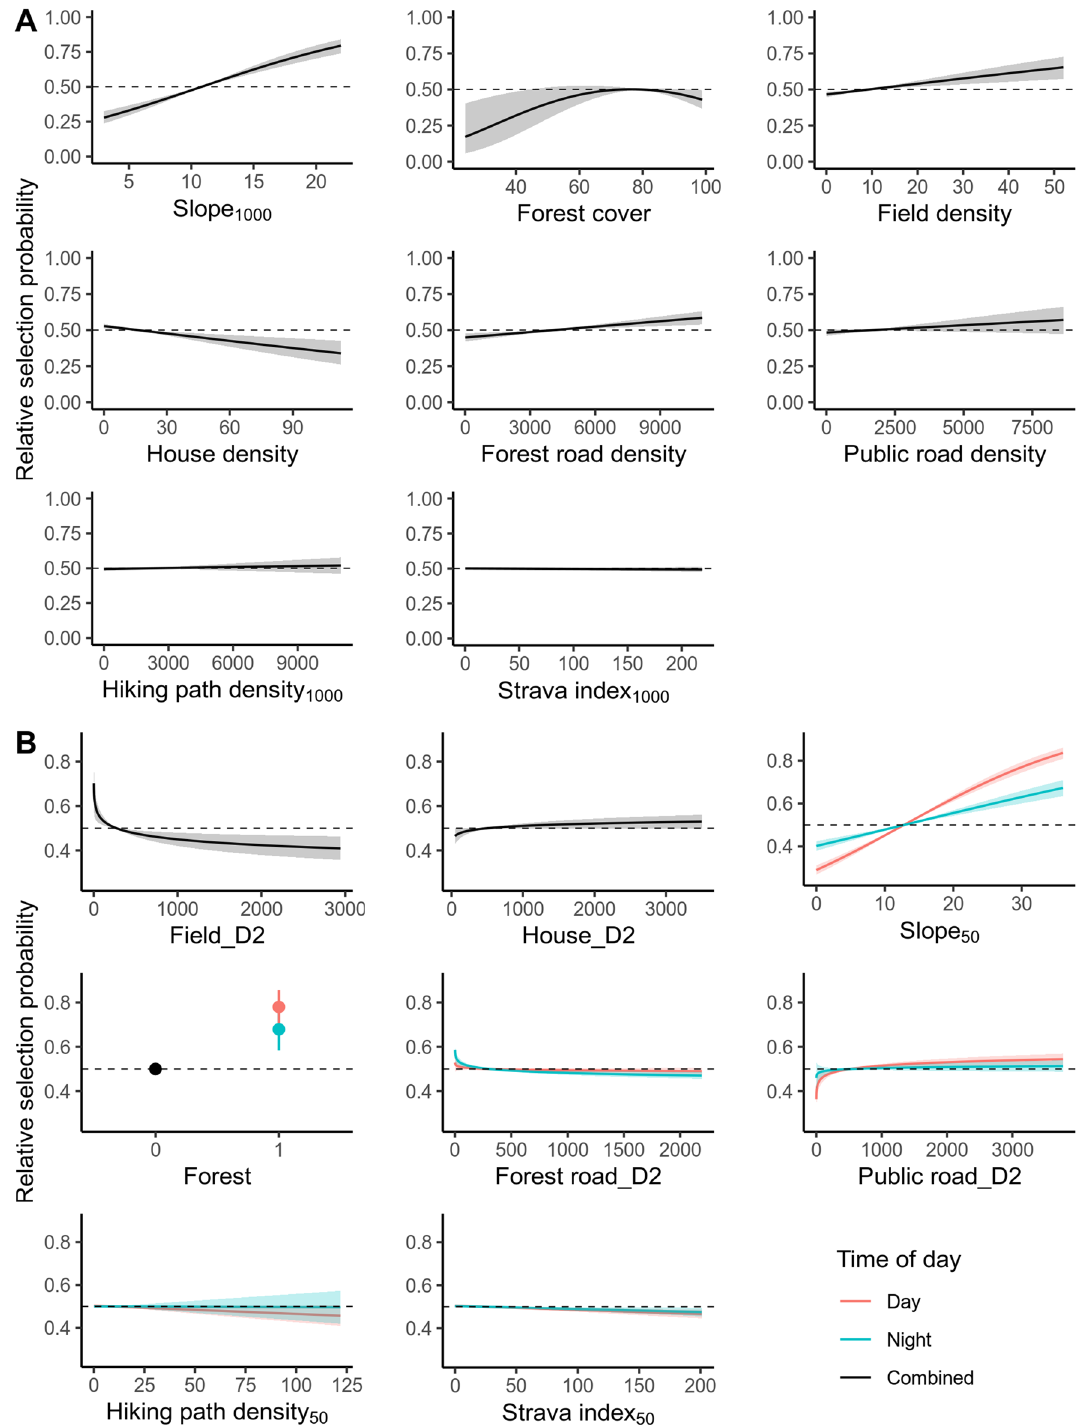
Figure 6. Predicted relative selection probability for each covariate for the home range-scale ( A ) and local- scale ( B ) habitat selection and their 95 % confidence interval. The range of the covariates (x-axes) is their 2.5 and 97.5% percentiles. Probabilities above the dashed horizontal line indicate selection and probabilities below indicate avoidance, relative to the “reference cell”. The reference cell, which all probabilities are relative to, is a cell where all the covariates are at their mean (due to the standardization prior to model fitting), and is not the same for home range-scale and local-scale habitat